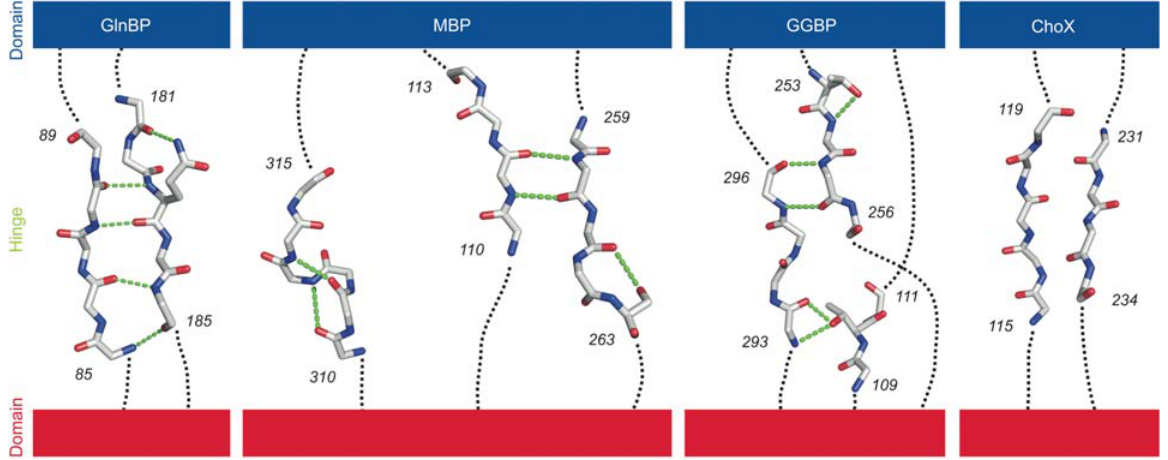
Figure 6 Hydrogen bond connectivity within hinge segments of open-unliganded crystal forms of GlnBP (PDB ID 1GGG), MBP (PDB ID 1OMP), GGBP (PDB ID 2FW0), and ChoX (PDB ID 3HCQ). Residue numbers at the end of each segment are indicated. Green, dashed lines denote hydrogen bonds. Side chains involved in hydrogen bonding are shown, as well as the complete polypeptide backbone (only heavy atoms included: C, gray; O, red; N, blue). Backbone covalent connections to the PBP domains are indicated by black, dotted lines. The domains are represented by red and blue rectangles (e.g., the N- and C-domains of MBP are denoted red and blue, respectively, as in Figure 1). Figure adapted from Ref. (30).